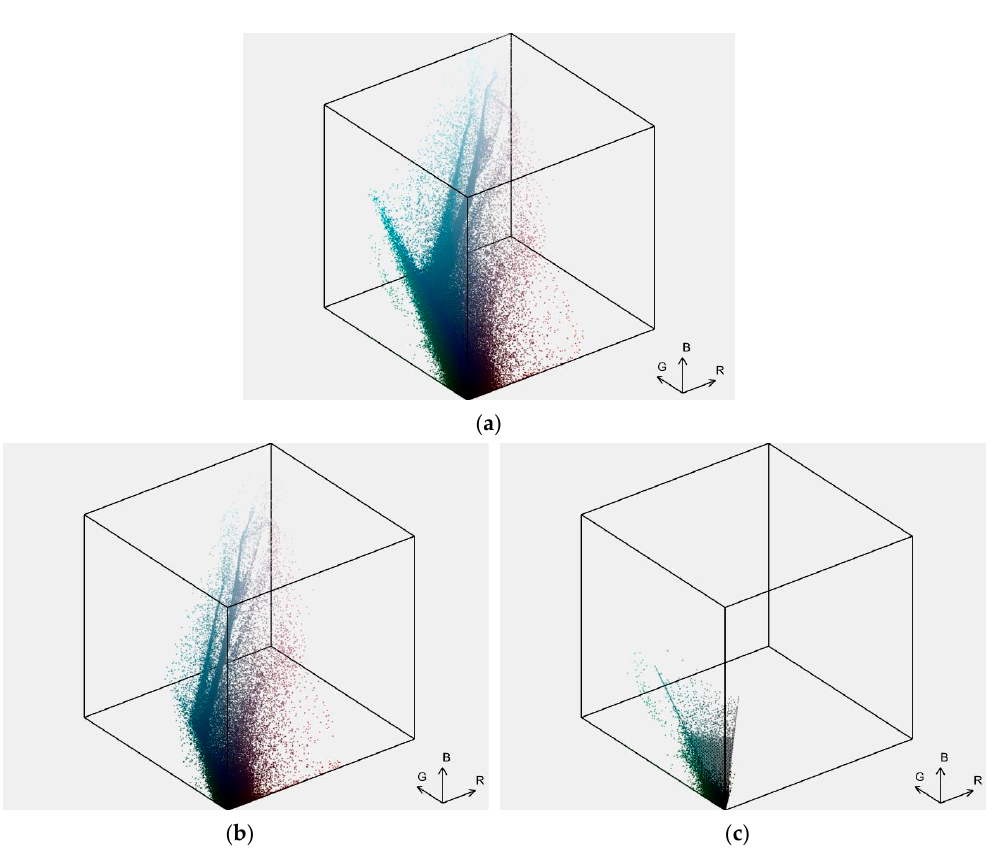
Figure 3. Pixel distributions over an RGB color cube as color clouds of the ( a ) original image (in Figure 2a), ( b ) ISED image of state 6 (in Figure 2b), and ( c ) corresponds to the ISED filter image (in Figure 2c).